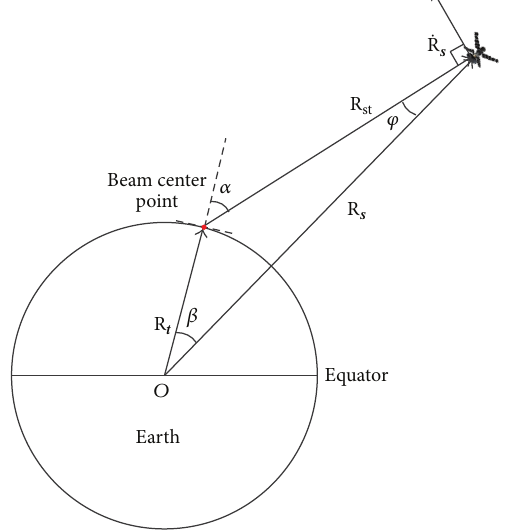
Figure 2: Geometry of the satellite after zero-Doppler centroid